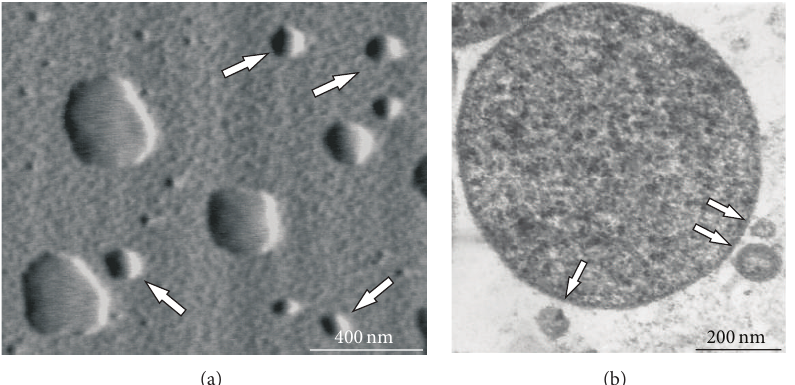
Figure 1: Atomic force microscopy (a) and transmission electron microscopy (b) images of Acholeplasma laidlawii PG8 cells and extracellular vesicles (indicated by